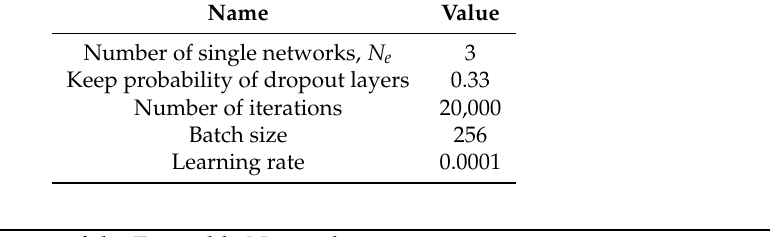
Algorithm 1 Training Process of the Ensemble Network.